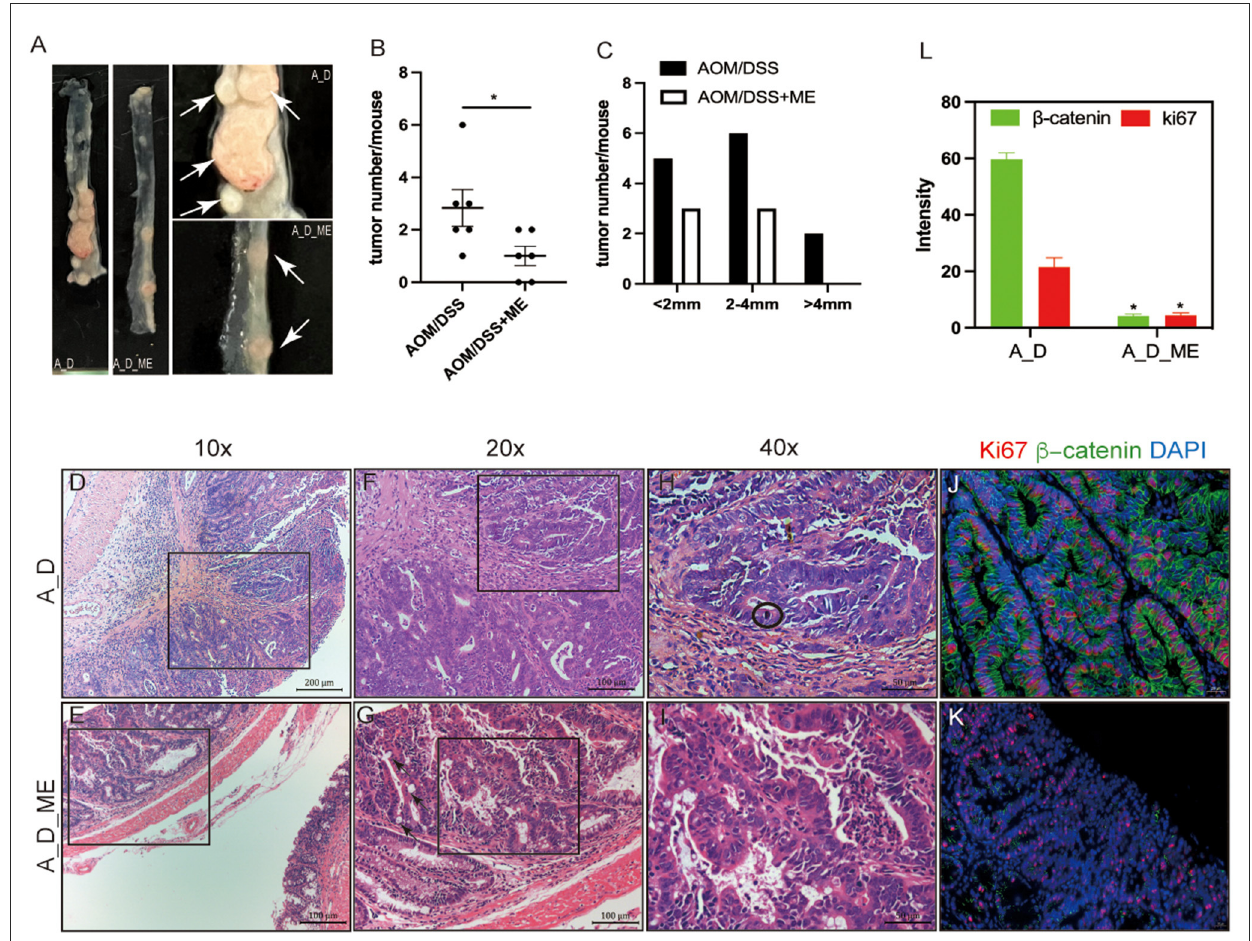
FIGURE2 Decreasing severity of inflammation and carcinogenesis in AOM/DSS-treated mice after ME administration. (A) tumors formed in the large intestinal tracts. The white arrow represents tumors. (B, C) numbers and distributions of tumors in the AOM/DSS mice ( n = 6 per group). (D–I) representative micrographs of H&E staining, (D, E) representative adenomas, infiltrating inflammatory cells in the surface of the rectum, scale bar = 200 µ m, 10 × magnification, (F, G) pathology damaged in the colonic mucosa, scale bar = 100 µ m, 20 × magnification, the black arrow represents intestinal metaplasia, (H, I) degree and type of cell differentiation, evaluation of mitotic figure can be hard(encircled). scale bar = 50 µ m, 40 × magnification. (J–L) immunofluorescent staining of ki67 (red) and β -catenin(green) in the adenocarcinoma of AOM/DSS model treated with ME or not, scale bar = 20 µ m, fluorescence intensity is analyzed by image J. Wilcoxon rank sum test was used, * p <